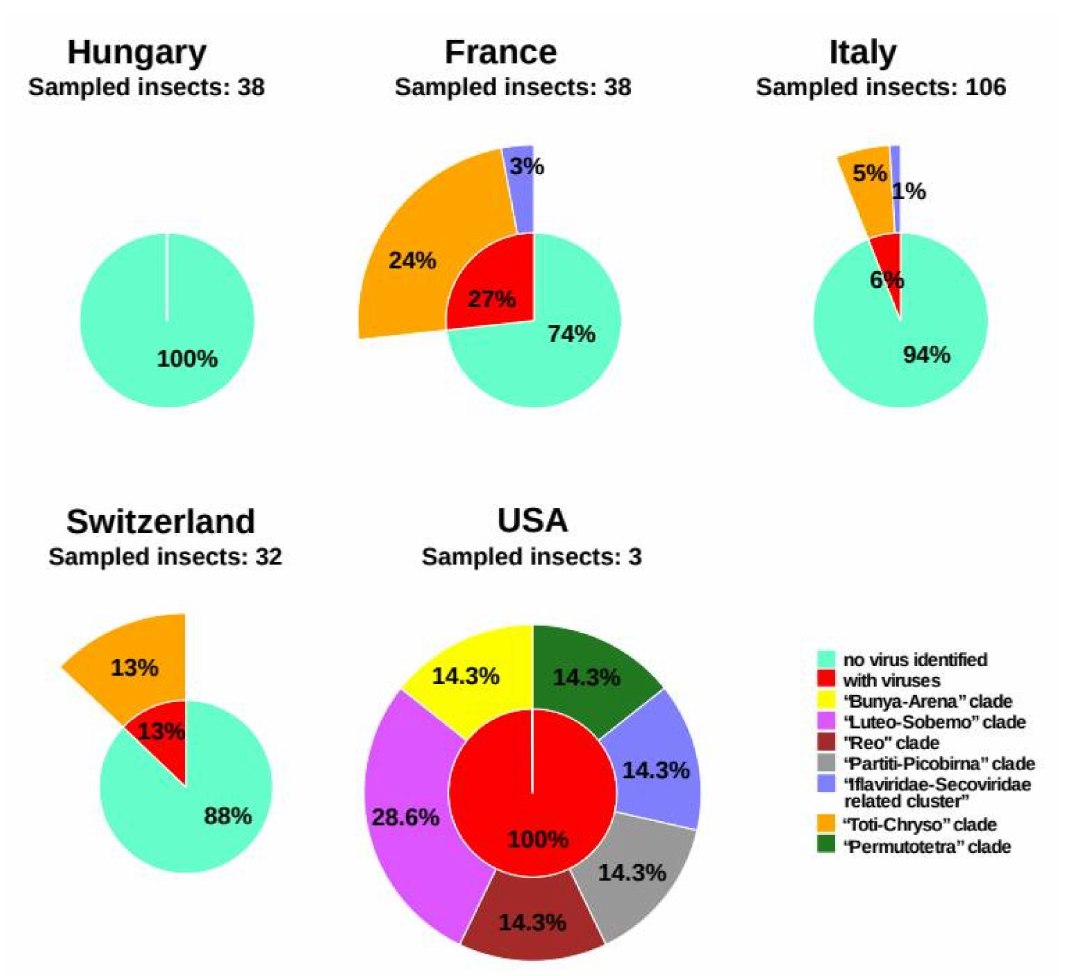
Figure 4. Virus clades and clusters identified in Europe and in the USA. Each sunburst reports prevalence of the newly identified virus in the 5 sampling countries and assignment to viral clades and clusters, according to Shi et al. [28] (see also Table 1). Sunbursts were generated by R (version 3.4.4) packages “cowplot” and